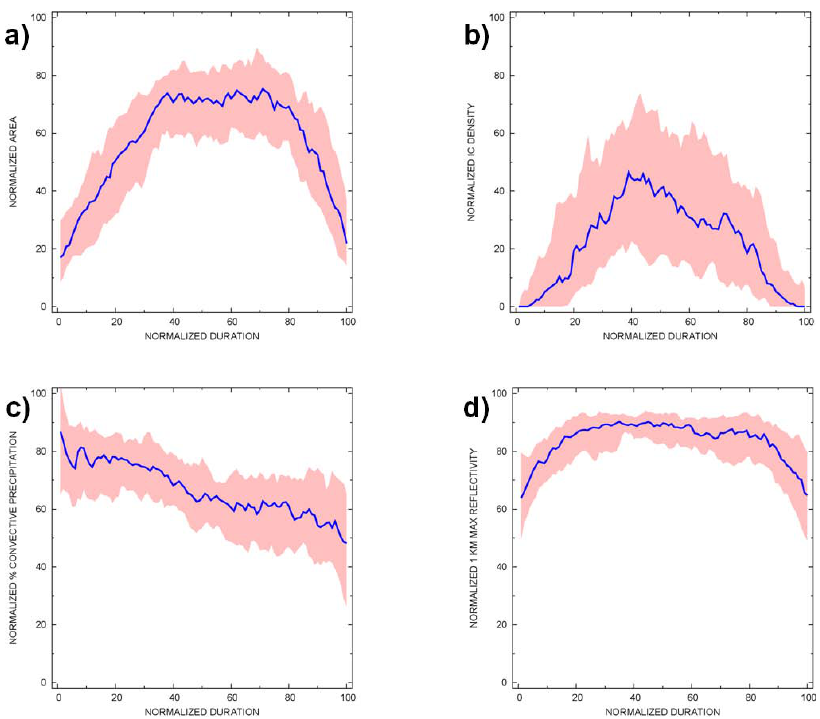
Fig. 7. Temporal evolution for different magnitudes of convective structures normalized with respect to maximum values reached (y-axis) and duration (x-axis). Each panel shows the area between the 25 and 75 percentile curves shaded and the 50 percentile curve (median) as a thick line. Normalized thunderstorm magnitudes shown are: (a) area; (b) intra-cloud flash; (c) proportion of convective precipitation; and (d) maximum reflectivity at 1-km CAPPI level.